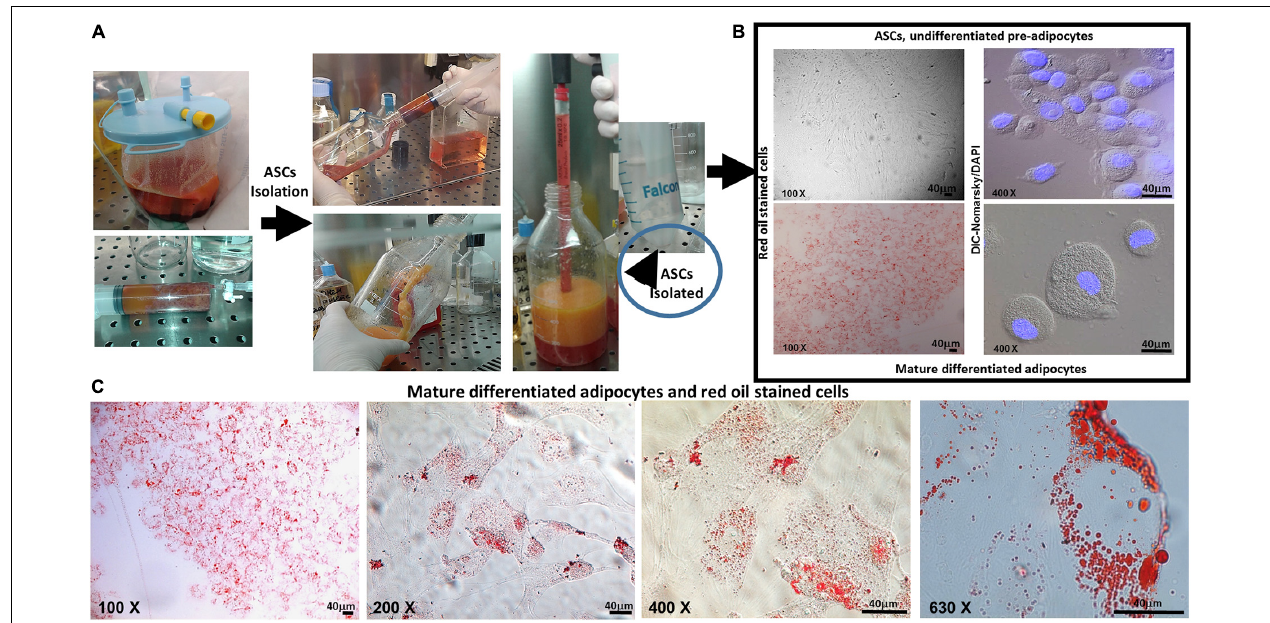
FIGURE 1 | (A) Isolation from liposuction sample. (B) Upper and lower left, ASCs and mature differentiated adipocytes, both stained with red oil ( × 100): upper left figure shows ASCs stained, negative for red oil test, and adherent in plasticware plate; lower left shows mature differentiated adipocytes stained, positive for red oil test, and adherent in plasticware plate. (B) Upper and lower right, differential interference contrast (DIC-Nomarski) combined with DAPI ( × 400) for ASCs and mature differentiated adipocytes is shown. (C) Mature differentiated adipocytes with red oil staining (magnification at × 100, × 200, × 400, and × 630, scale bar = 40 µ m) are shown. Axioskop-2-Zeiss